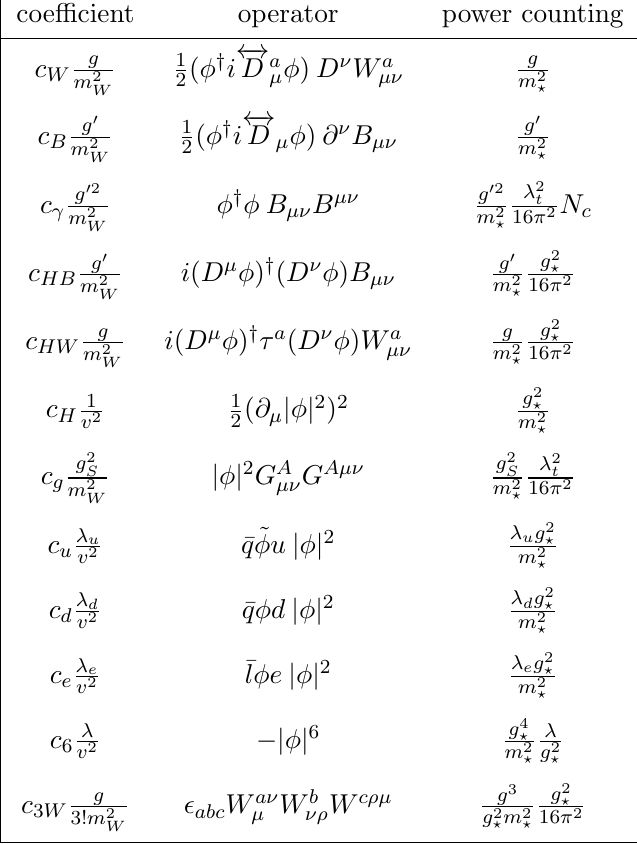
Table 3 . SILH operators, their coe(cid:14)cients in refs. [36, 37], and the power counting adopted here for the